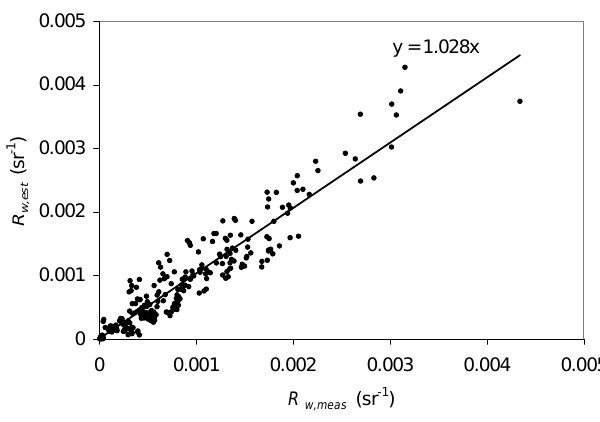
Figure 7. Estimated vs. measured values of the water-leaving radi- ance L w for all data sets and wavelengths. Table 6. Values of A and C and the measured radiance reflectance R r, meas at 560nm for all data sets taken together and for the test case with A and C determined from 9 data sets and applied on the remaining 13 data sets. The rms represents the deviations between R r, meas and the corresponding estimated values of R r, est